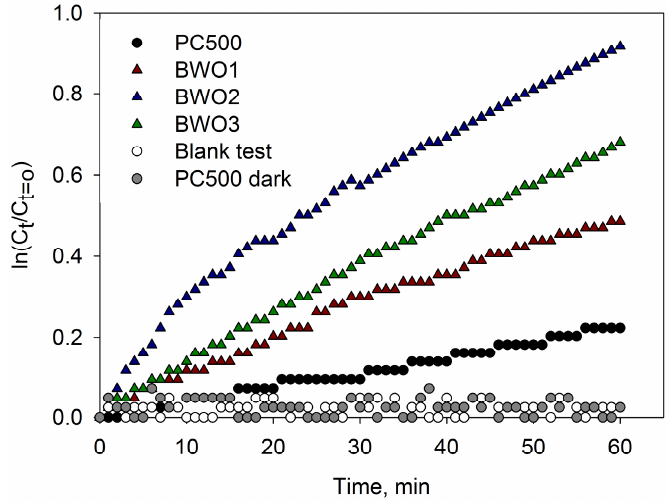
Figure 6. CO 2 evolution kinetics in contact with bismuth tungstate-coated and uncoated titania samples under visible light irradiation.